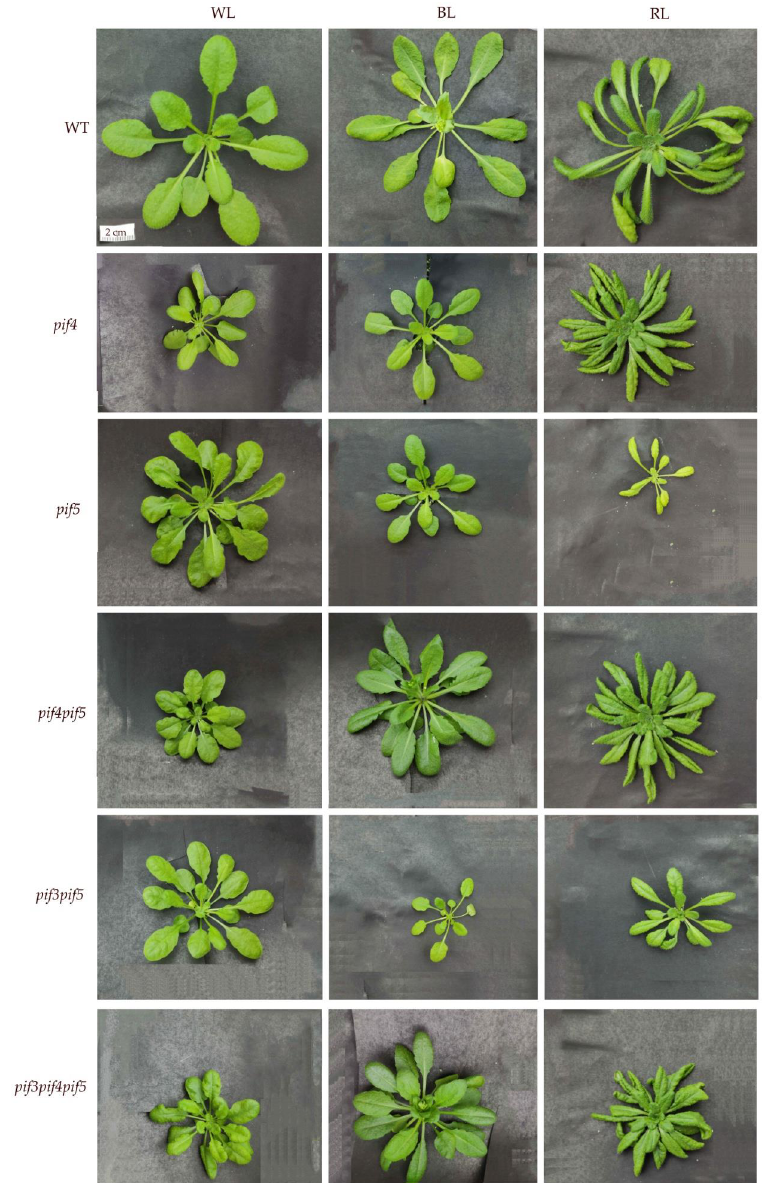
Figure 2. Effect of light with different spectra on the phenotype of four-week-old A. thaliana pif mutants.